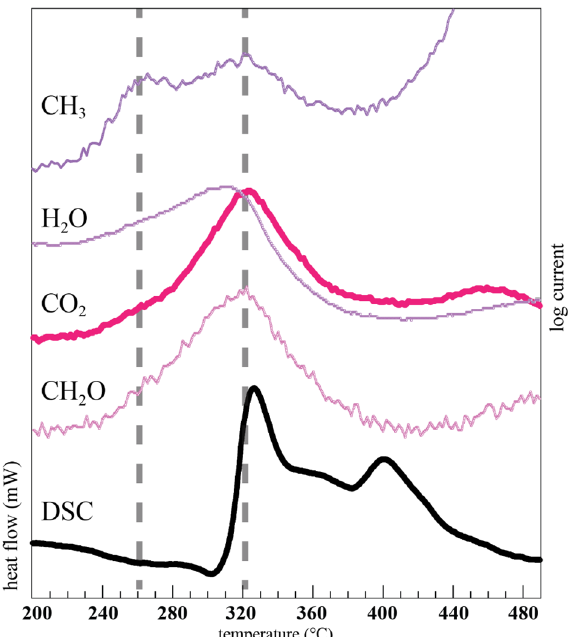
Figure 6. Comparison of the exothermic DSC region (in mW) for the FSY sample run under He (bottom curve) compared with selected EGA profiles (log current) corresponding to CH 2 O + (m/z = 30), 12 CO 2 + (m/z = 44), H 2 O + (m/z = 18), and CH 3 + (m/z = 15). Additional potential gas assignments are listed in Table S7. All profiles are scaled and shifted along the y-axis so as to show the correspondence between the peak maxima. The absolute EGA scales are shown in Fig.